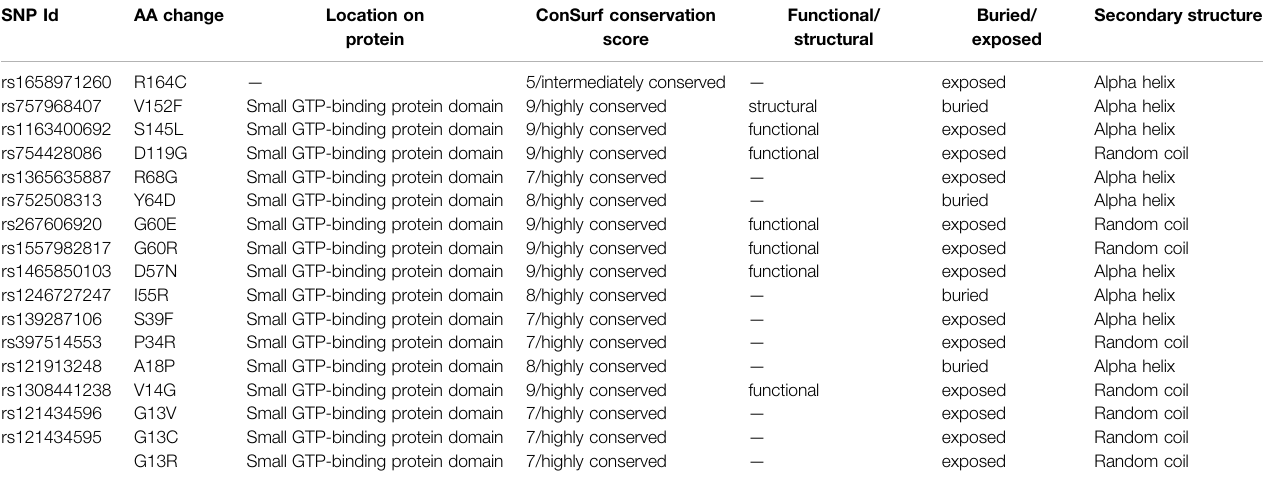
TABLE 3 | Locations of NRAS variants on protein domains, phylogenetic conservation analysis, and secondary structure